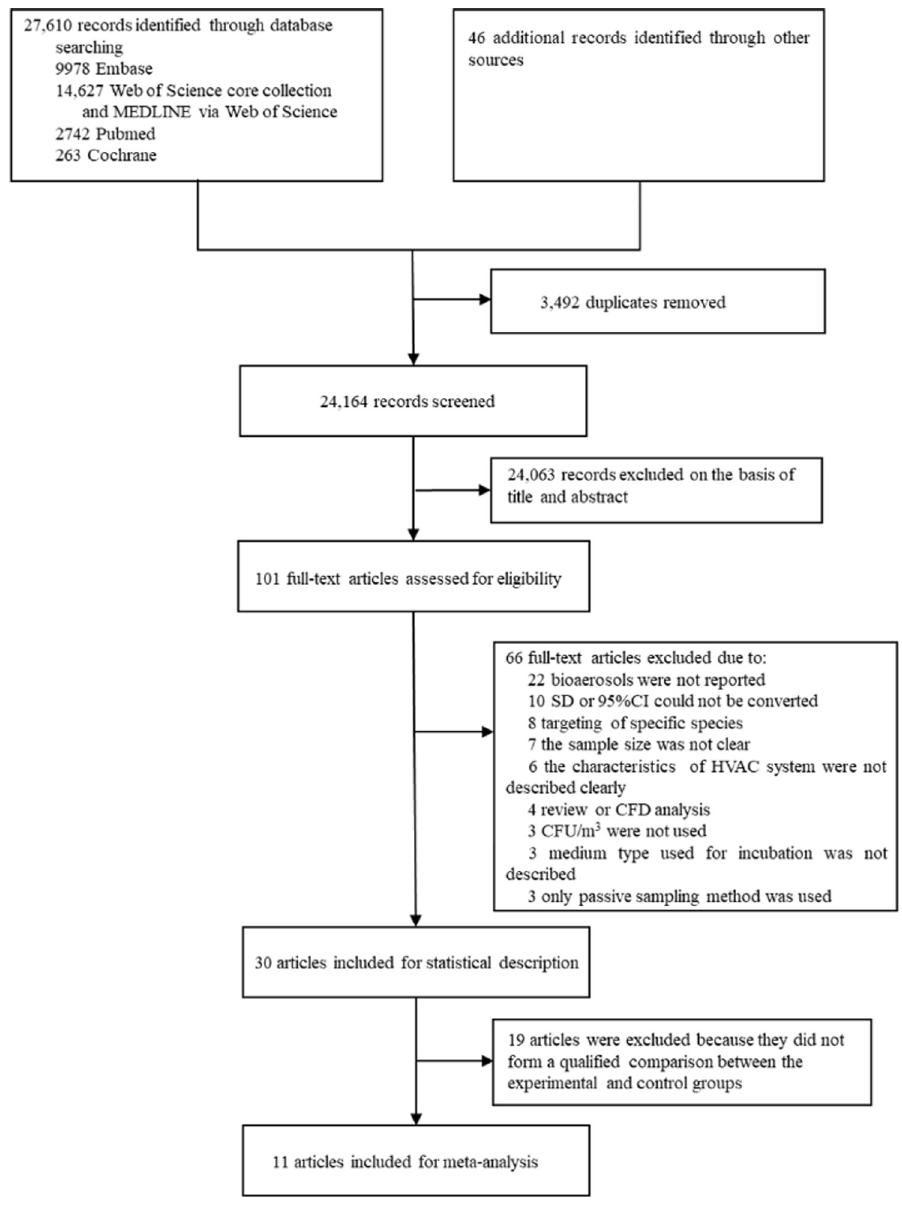
Fig 1. Flow diagram of study